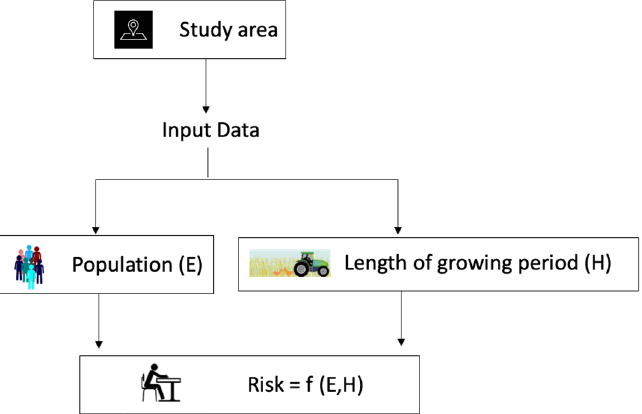
Figure 3. Workflow to measure future climate risk through the change in length of growing period (LGP) and population. Table 2. Summary of population and change in length of the growing period in the Analamanga region, Madagascar.